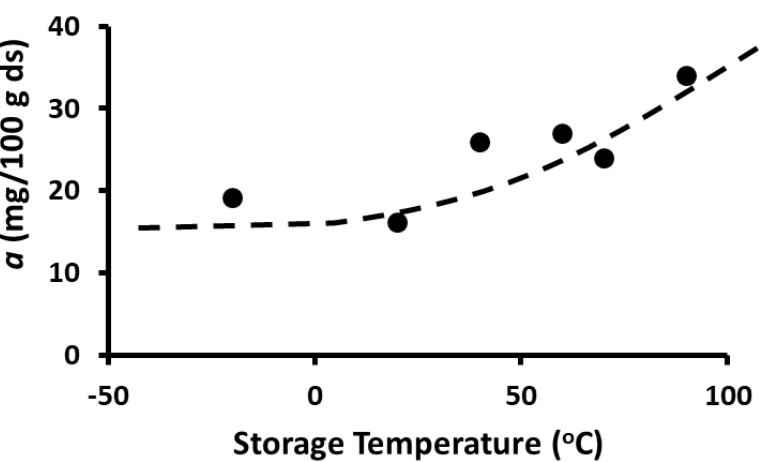
Figure 7. Peak polyphenol concentration as a function of storage temperature (line is a trend guide).